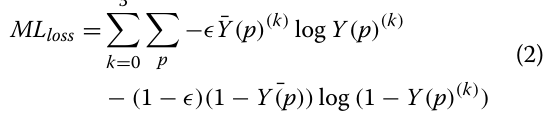
K = 3 with one category corresponding to the physical ˆ Y edges ( ), one for the nonphysical edges ( V d − the rest of the pixels corresponding to the background.